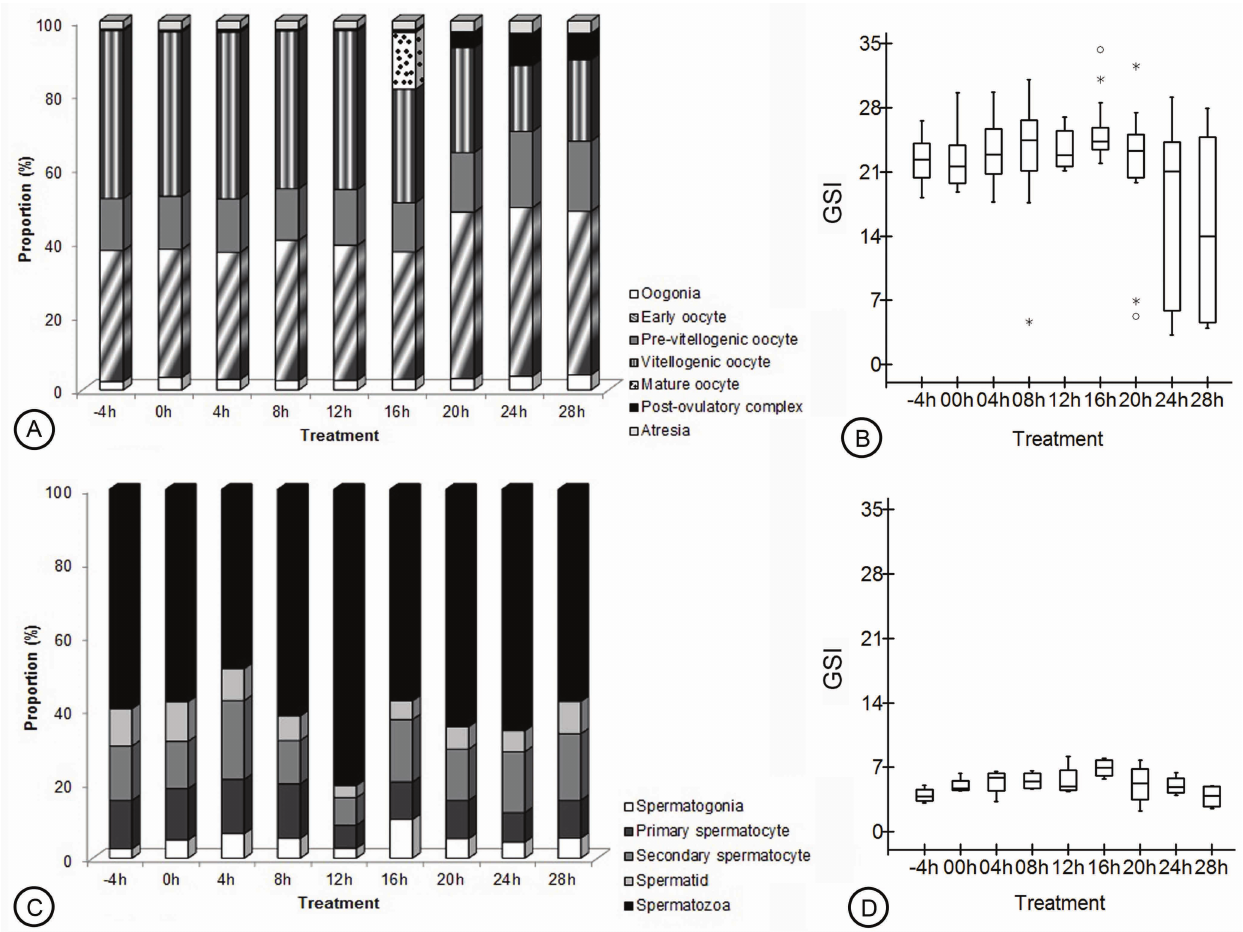
Fig. 2. Quantitative analyses of the gonads. (A) Plot of female germ cells proportion though sampling times; (B) Variation in female gonadosomatic index (GSI) over the sampling times (H=16.388, p=0.037); (C) Plot of male germ cells proportion though sampling times; (D) Variation in male gonadosomatic index (GSI) over the sampling times (F=1.806,